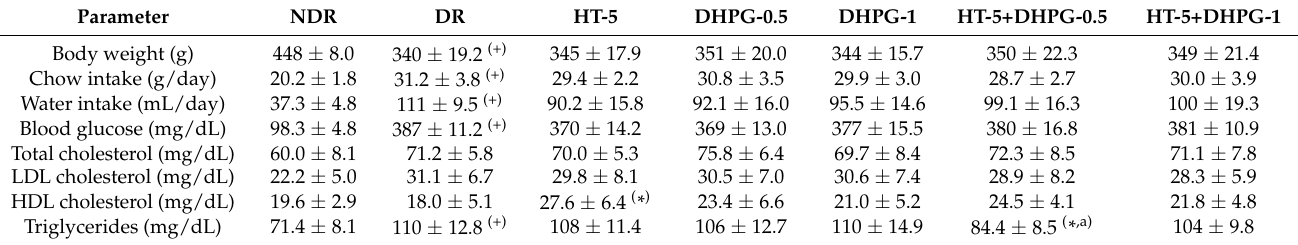
Table 1. Zoometric and serum biochemical parameters (mean ± standard deviation) of non-diabetic rats (NDR); diabetic rats (DR); and DR treated with hydroxytyrosol 5 mg/kg/day p.o. (HT-5), 3 (cid:48) ,4 (cid:48) - dihidroxifenilglicol (DHPG) 0.5 or 1 mg/kg/day p.o. (DHPG-0.5, DHPG-1), or their associations. N = 10 rats per